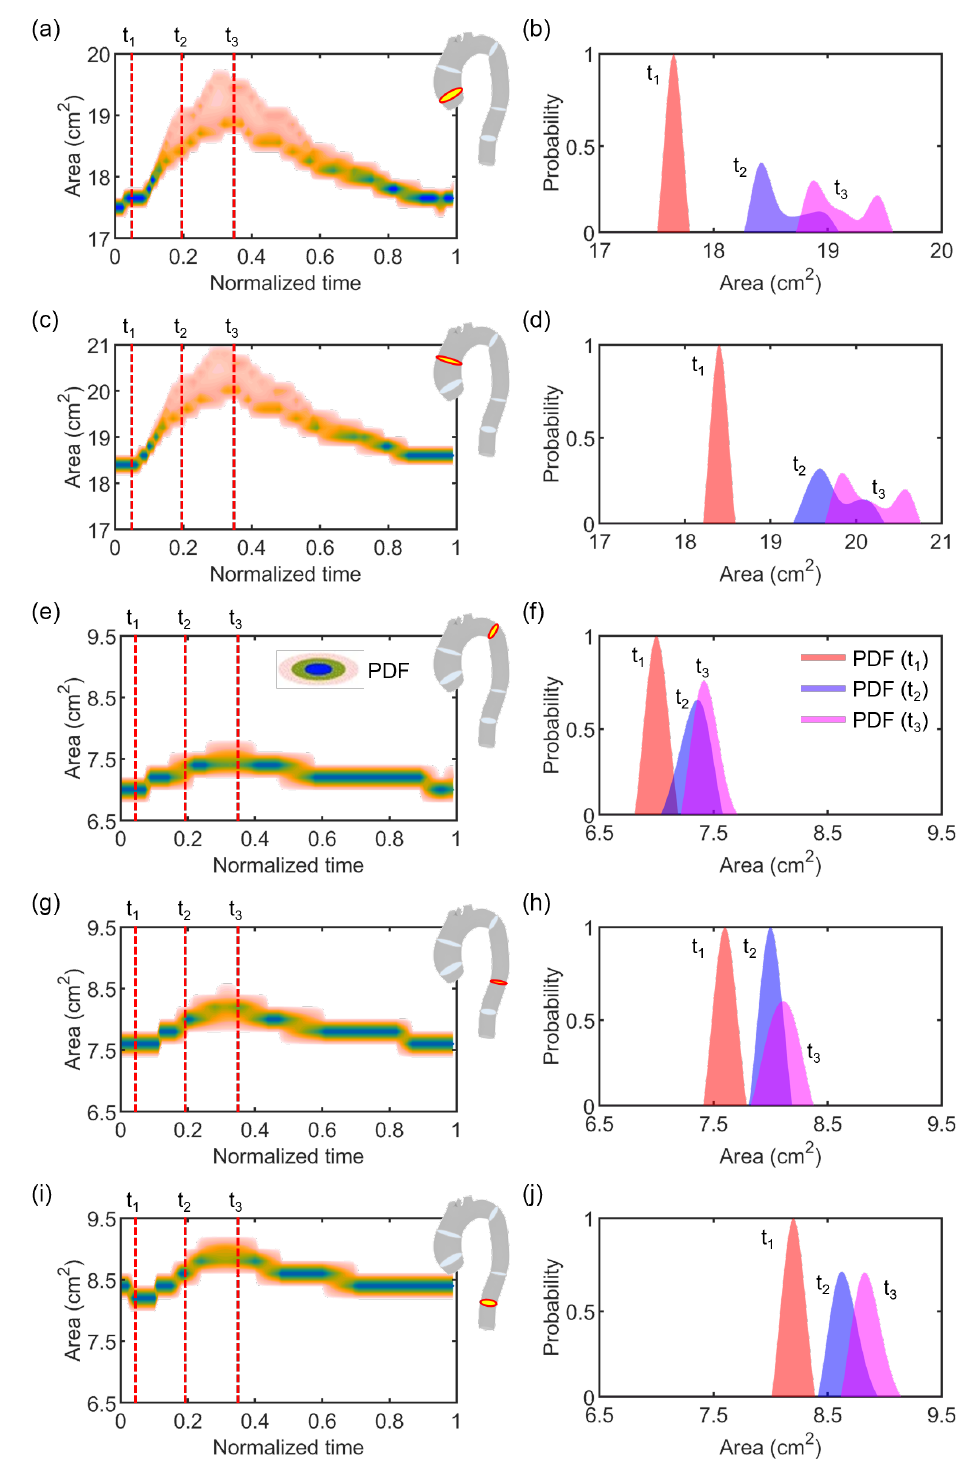
Figure 10. PDFs of area variation at the five cross-sections, i.e., CS 1 ( a , b ), CS 2 ( c , d ), CS 3 ( e , f ), CS 4 ( g , h ), and CS 5 ( i,j ) along the entire cardiac cycle ( a , c , e , g , i ) and at the time instances t 1 , t 2 , and t 3 of the cardiac cycle ( b , d , f , h , j